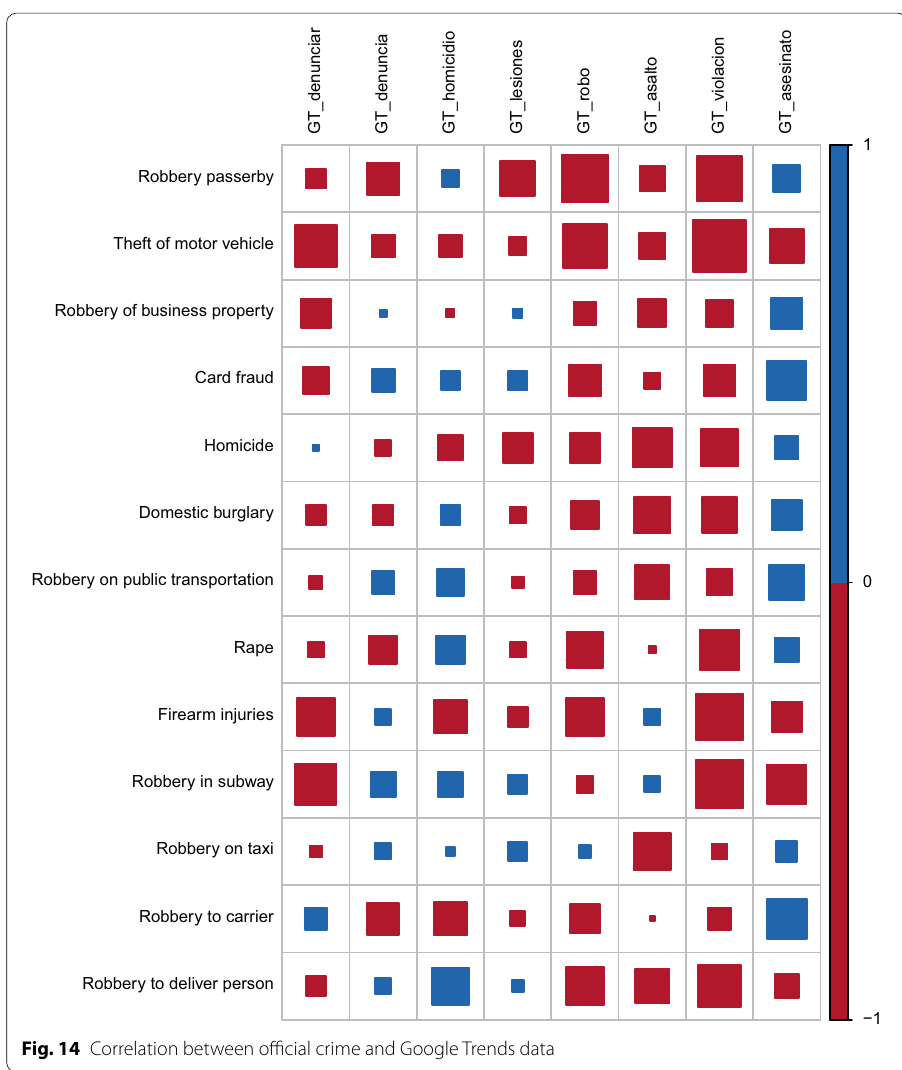
Fig. 14 Correlation between official crime and Google Trends